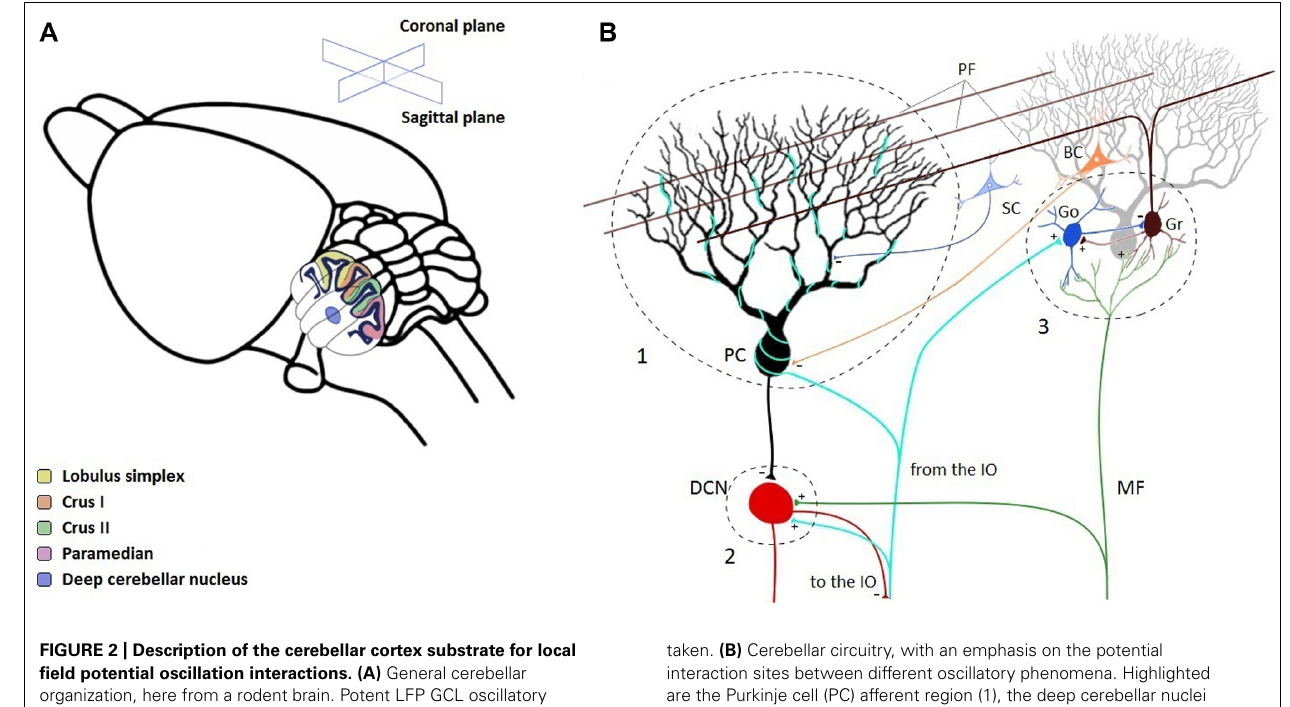
FIGURE 2 | Description of the cerebellar cortex substrate for local field potential oscillation interactions. (A) General cerebellar organization, here from a rodent brain. Potent LFP GCL oscillatory sites can be recorded from within the cerebellar cortex posterior lobe, including the crus lobules, Crus II and Crus I, and the paramedian lobule (PM). For both the primate and the rodent, the PM lobule is a common GCL LFP oscillation recording site, at the level where the virtual slice is